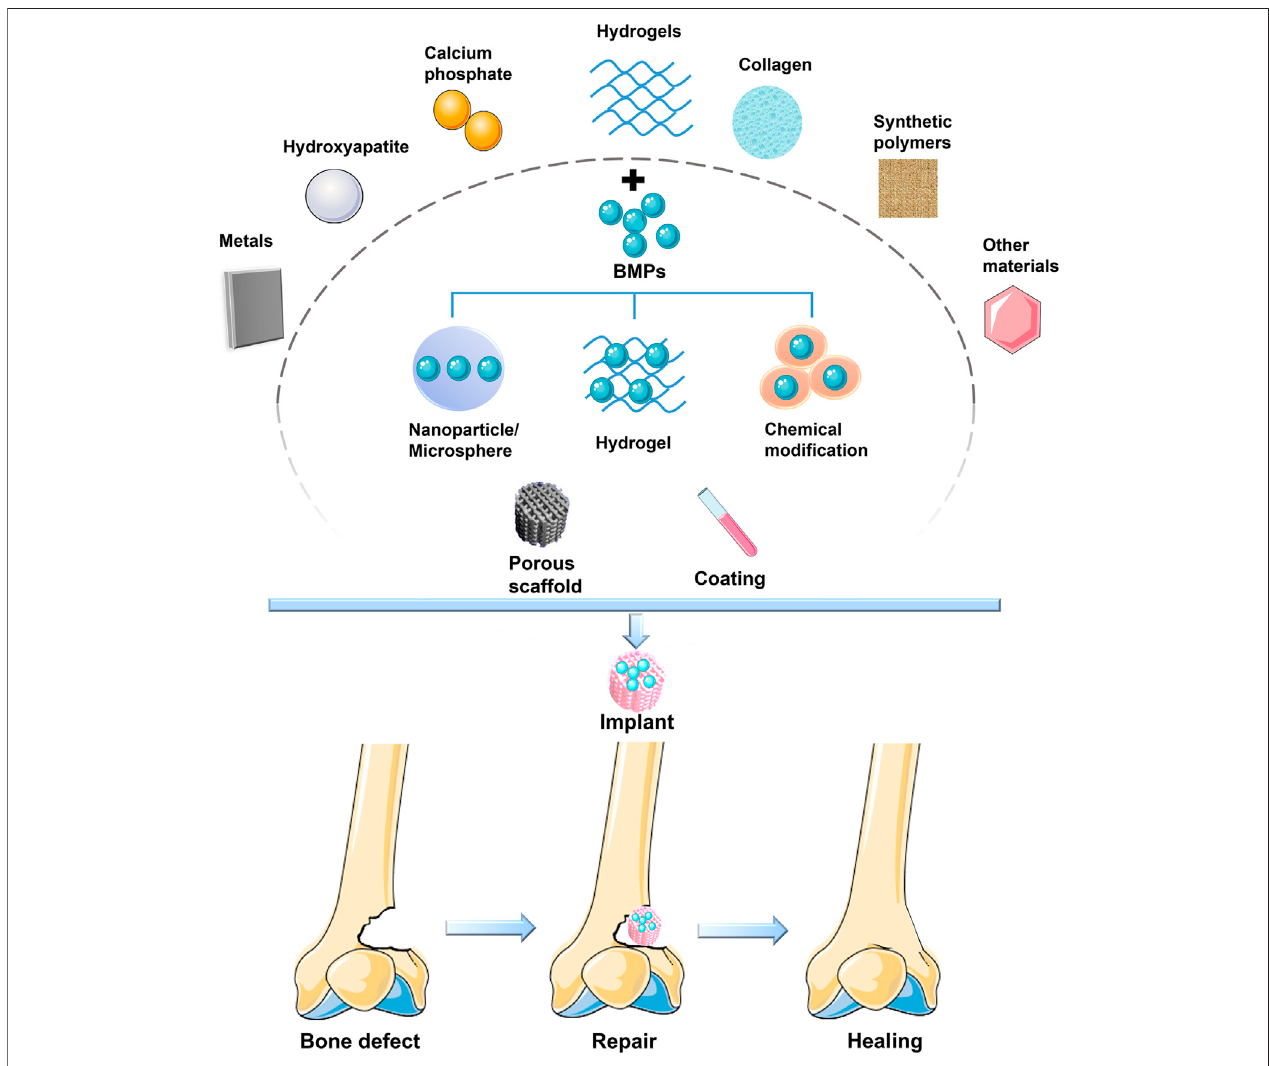
FIGURE 2 | BMP is loaded on various materials to form a bioactive scaffold to promote bone defect healing.